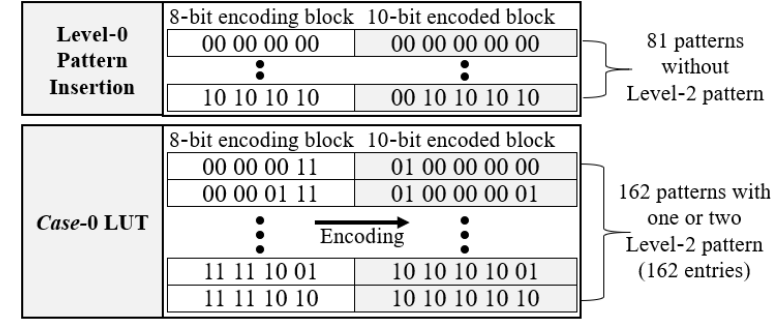
Figure 4. Case-0 encoder configuration.